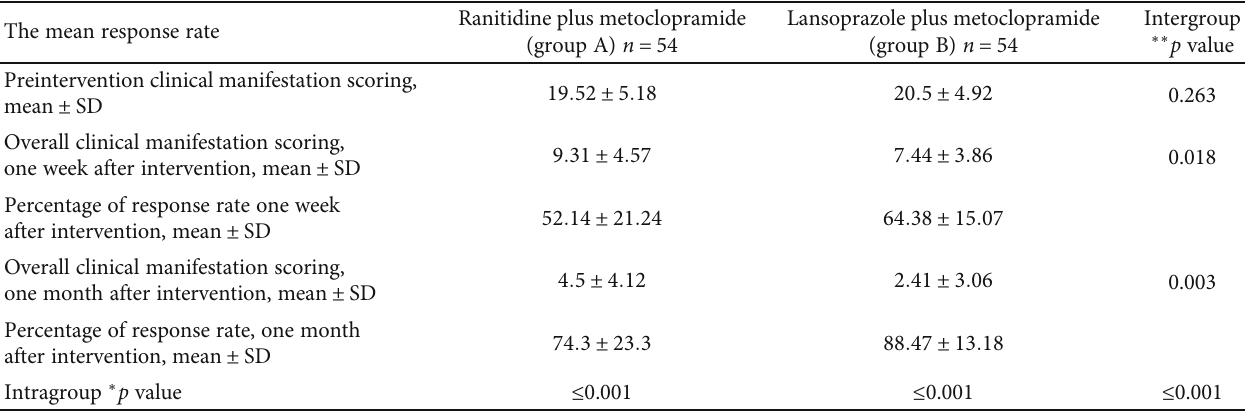
Table 5: The changes of GERD-related scoring of clinical manifestations and percentage of response rate one week and one month after